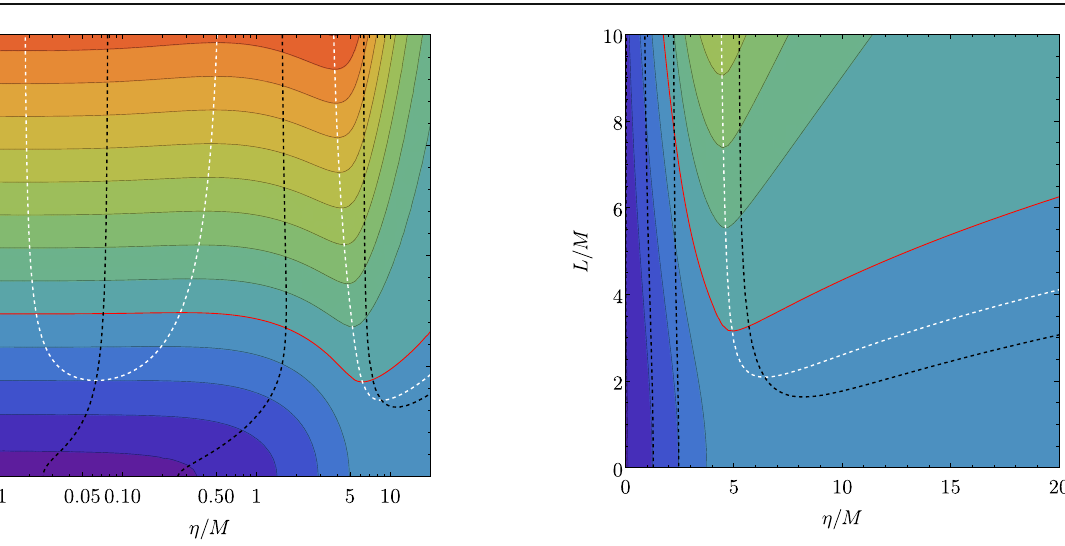
Fig. 32 Same as Fig. 26 for the wormhole solution of Fig. 31